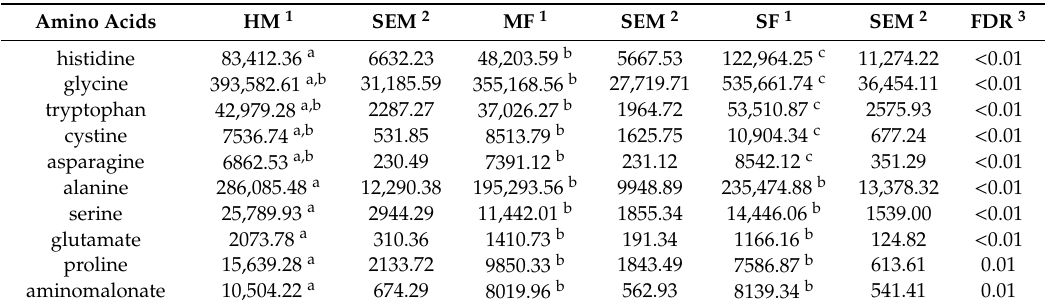
Table 3. Average abundances (quantifier ion (quantion) intensities) of urinary amino acids significantly di ff erent when comparing human milk (HM; n = 93), cow’s milk-based formula (MF; n = 80), and soy-formula (SF; n = 76) diet groups of infants at 3 months of age.